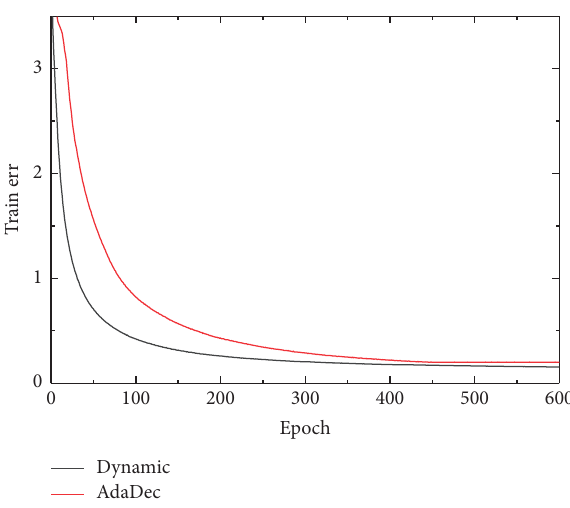
Figure 7: The training errors between dynamic and